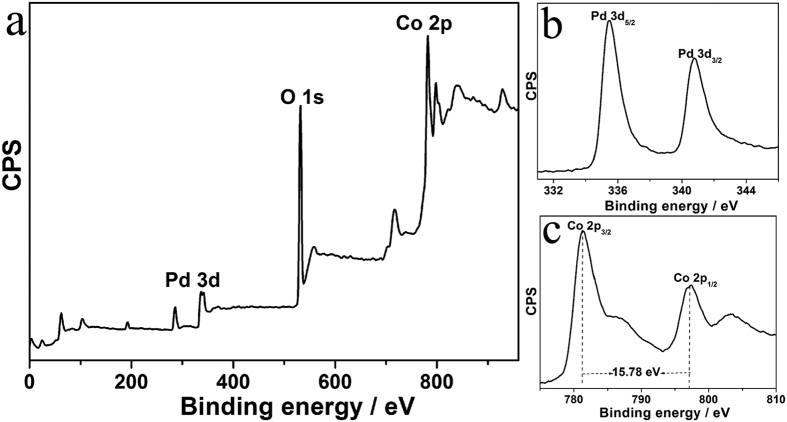
XPS spectra (a) overall, (b) Pd 3d and (c) Co 2p of mesoporous Co3O4 and Pd-Co3O4 (wt 1:1).